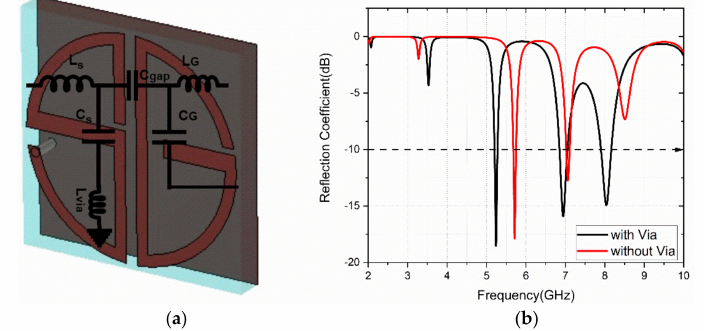
Figure 3. ( a ) Unit cell equivalent LC-circuit model representation; ( b ) Comparison of S 11 with and without